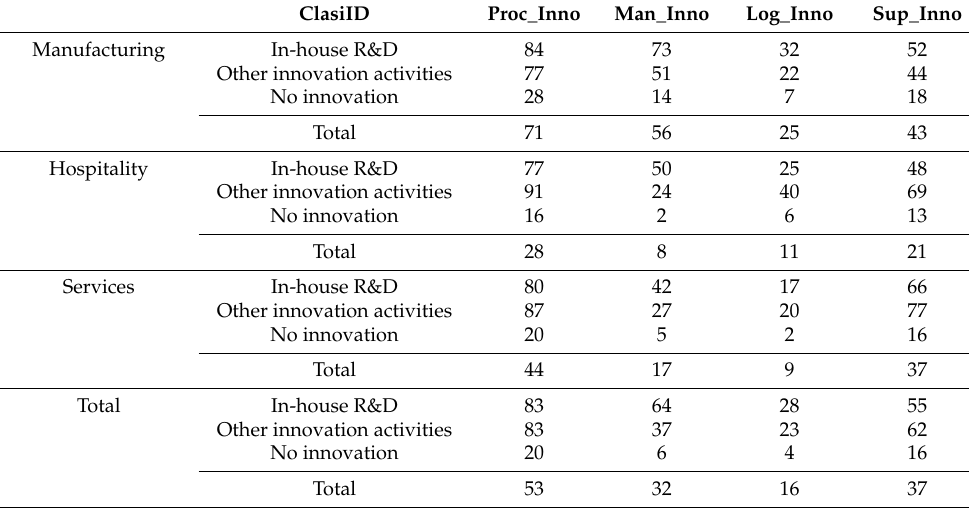
Table 12. Process innovators by industry (%).